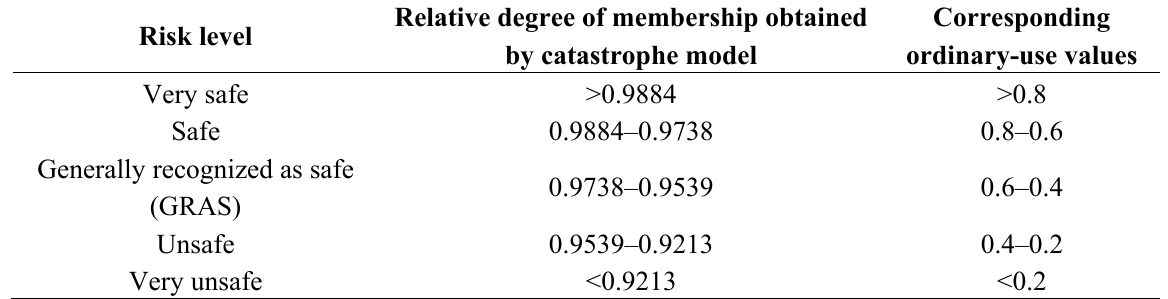
Table 3. Corresponding values between risk assessment results of catastrophe model and ordinary-use values at different risk levels.